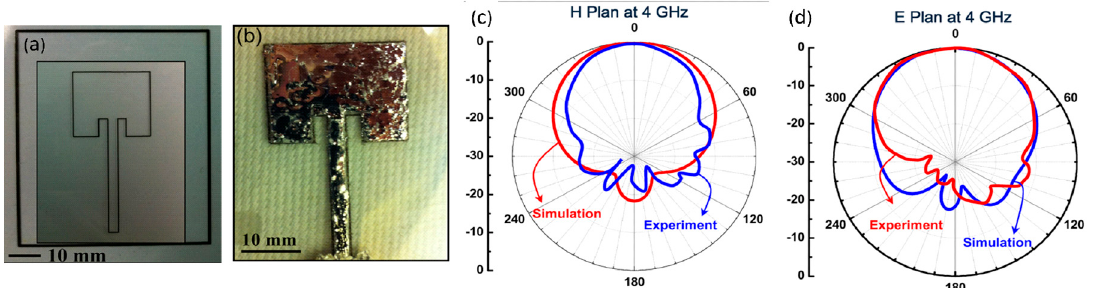
Figure 5. ( a ) Antenna frame generated by UV-assisted direct writing technology on a PDMS substrate; ( b ) fabricated antenna with EGaIn / SWNTs nanocomposite; ( c ) H-plane; and ( d ) E-plane pattern comparison for simulated and measured response